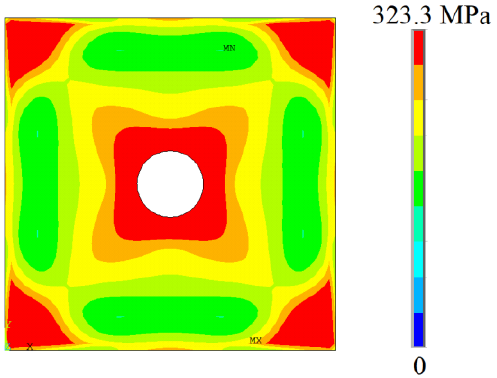
Figure 14. The von Mises stress distribution for the square plate with centered hole.